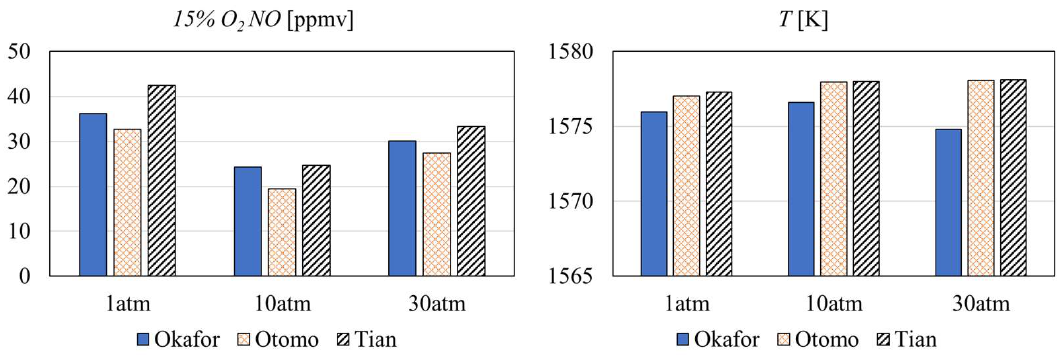
Figure 11. Effects of reactor pressure and chemical mechanism in FS CRN.